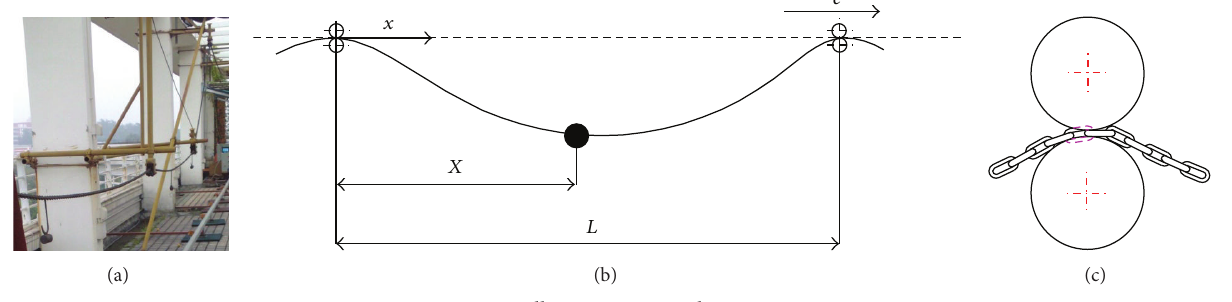
Figure 1: Axially moving monochain